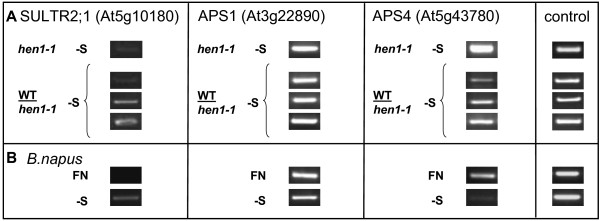
Analysis of the targets of miR395 in roots. Analysis of the mRNA levels of the miR395 targets SULTR2;1, APS1 and APS4 by semi-quantitative RT-PCR. A: PCR results from root tissue of hydroponically grown Arabidopsis hen1-1 mutants and WT/hen1-1 rootstocks (35 cycles, UBC10, At5g53300 served as a control). B: Changes of target mRNAs in B. napus roots under -S compared to full nutrition (FN) (35 cycles, UBP1B, At1g17370 served as a control).